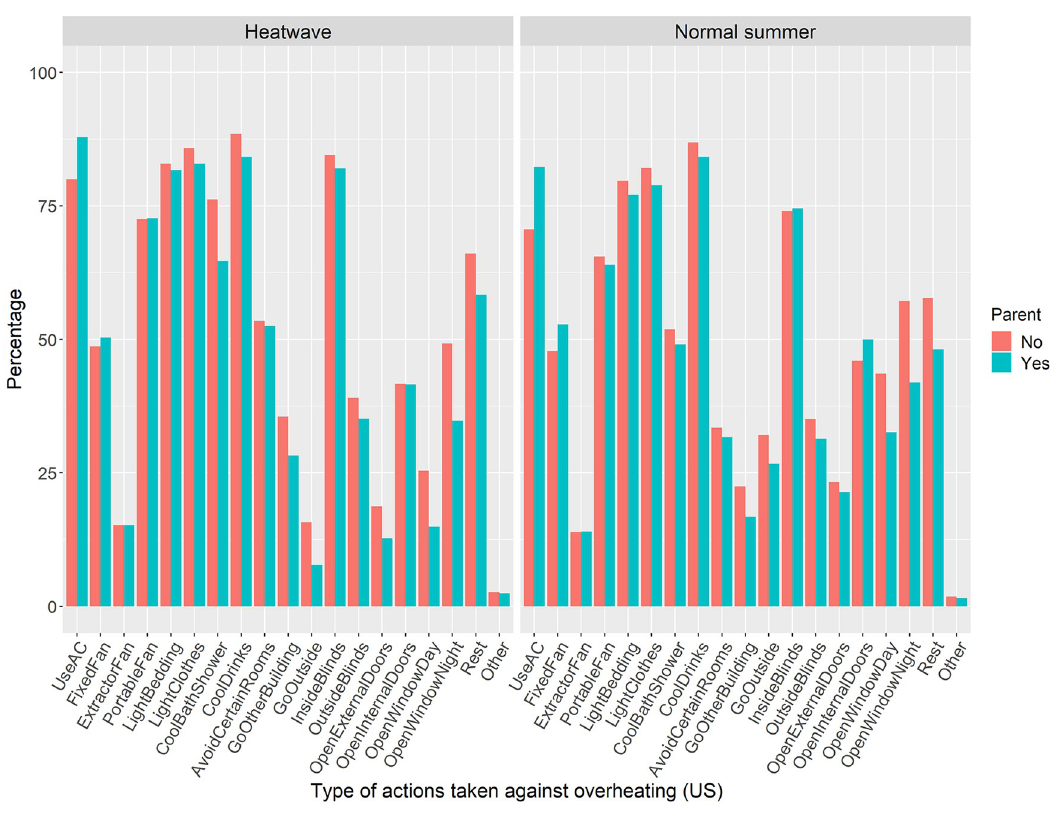
Fig 3. Type of overheating actions taken during a heatwave and a normal summer in the US, split up by parental